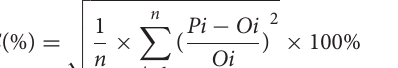
evaluated by employing the R 2 , RMSE, and RE (%). Among the indices, those with the highest R 2 and the lowest RMSE and RE were considered as the best. RMSE and RE were calculated from actual and predicted values of samples according to Equations (2) and (3),